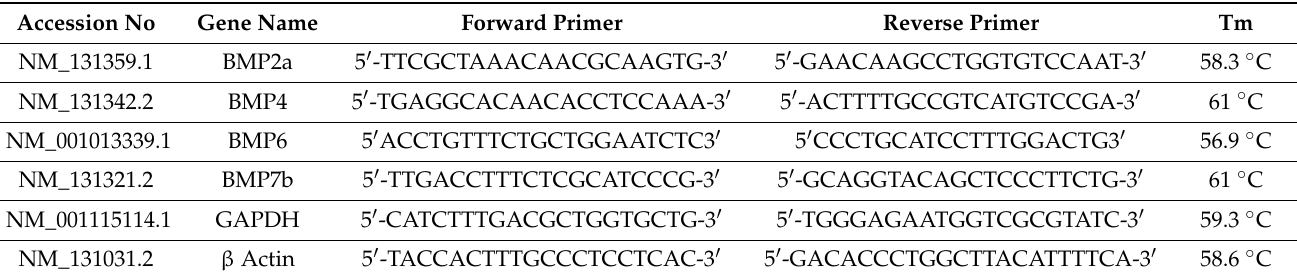
Table 2. List of primers used in